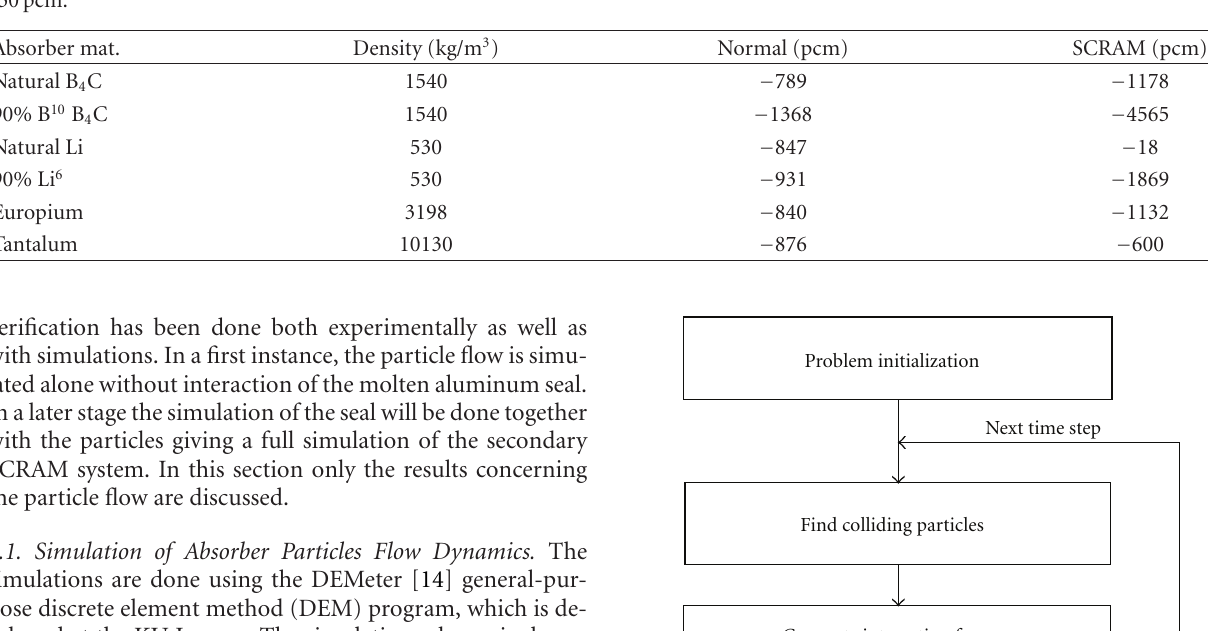
Table 1: Impact on normal operation and SCRAM worth for di ff erent neutron absorbing materials in per cent mille (pcm). For all materials except lithium, which is a liquid at the working temperatures, 61% of the theoretical density was used. Uncertainty on these values is about 150pcm.